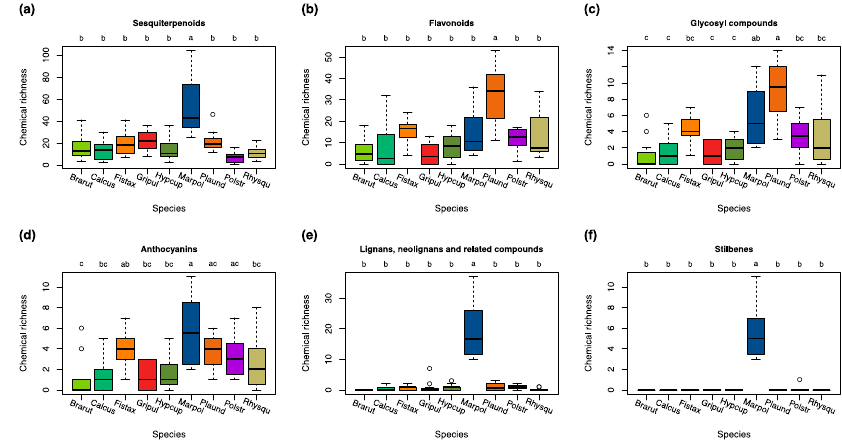
Figure 3. Richness of chemical entities of the different bryophyte species within the chosen chemical classes of ( a ) sesquiterpenoids; ( b ) flavonoids; ( c ) glycosyl compounds; ( d ) anthocyanins; ( e ) lignans; neolignans, and related compounds; and ( f ) stilbenes. Differences among groups (letters on the top of the plot) are based on the Tukey HSD post hoc test on a one-way ANOVA. Different letters show significant differences ( p < 0.05). n = 12 for each species. Red colors represent acrocarpous mosses. Green colors represent pleurocarpous mosses. A blue color represents liverworts.